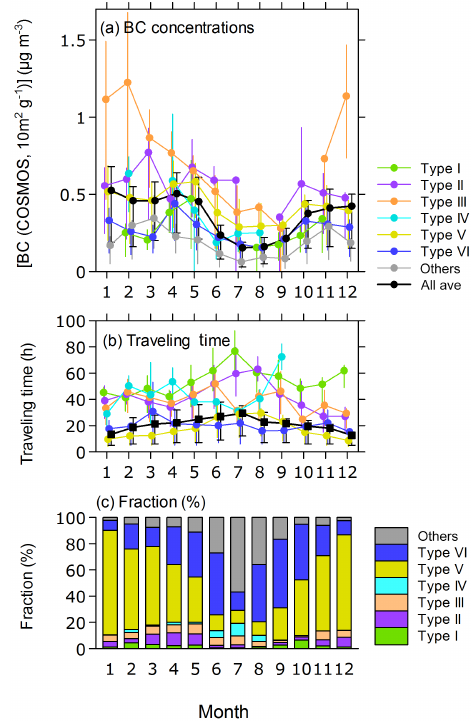
Figure 5. Seasonal variations in (a) BC concentrations and (b) trav- eling times from borderlines for all cases (black line) and for indi- vidual air mass types (colored lines). Averages (solid circles) and interquartile ranges (bars) are shown. (c) Fractions of air mass types for each